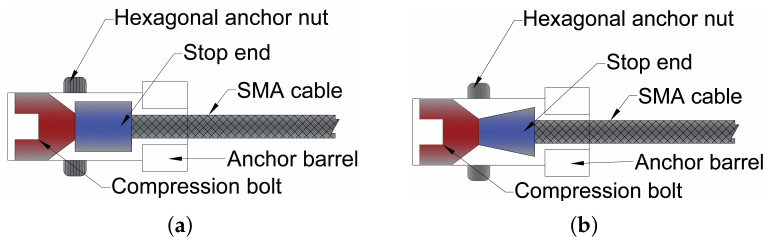
Figure 15. ( a ) Schematic of first SMA-based anchorage system; ( b ) schematic of second SMA-based anchorage system [70].